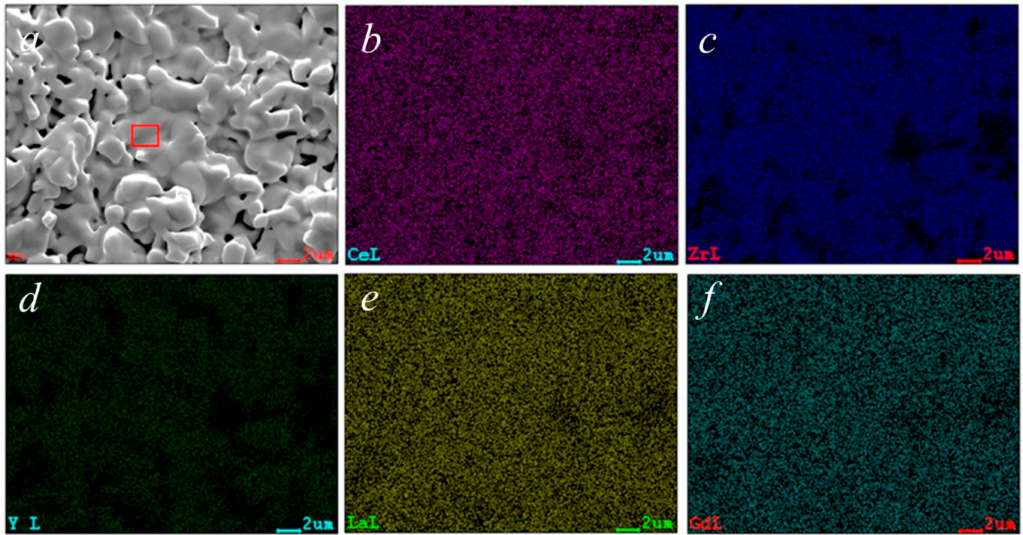
Figure 6. Scanned area for chemical analysis by EDS (Figure 6 a ) and mapping of all cations in the